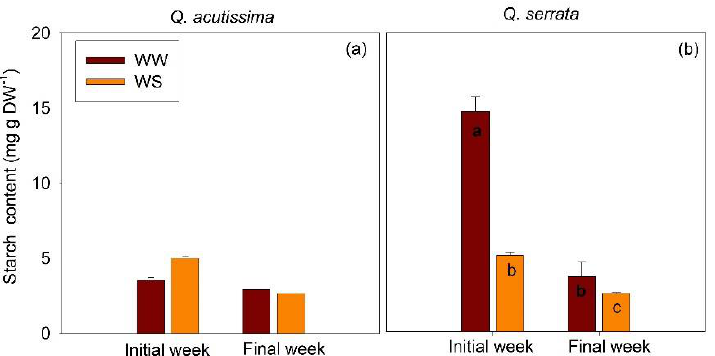
Figure 9. Starch content of ( a ) Quercus acutissima and ( b ) Q. serrata in well-watered (WW) and water-stressed (WS) treatments. Vertical bars indicate the SE (n = 8). Comparison means derived using Tukey’s test ( p < 0.05) are shown for the significant interaction between water stress and time. Different lowercase letters indicate significant differences.